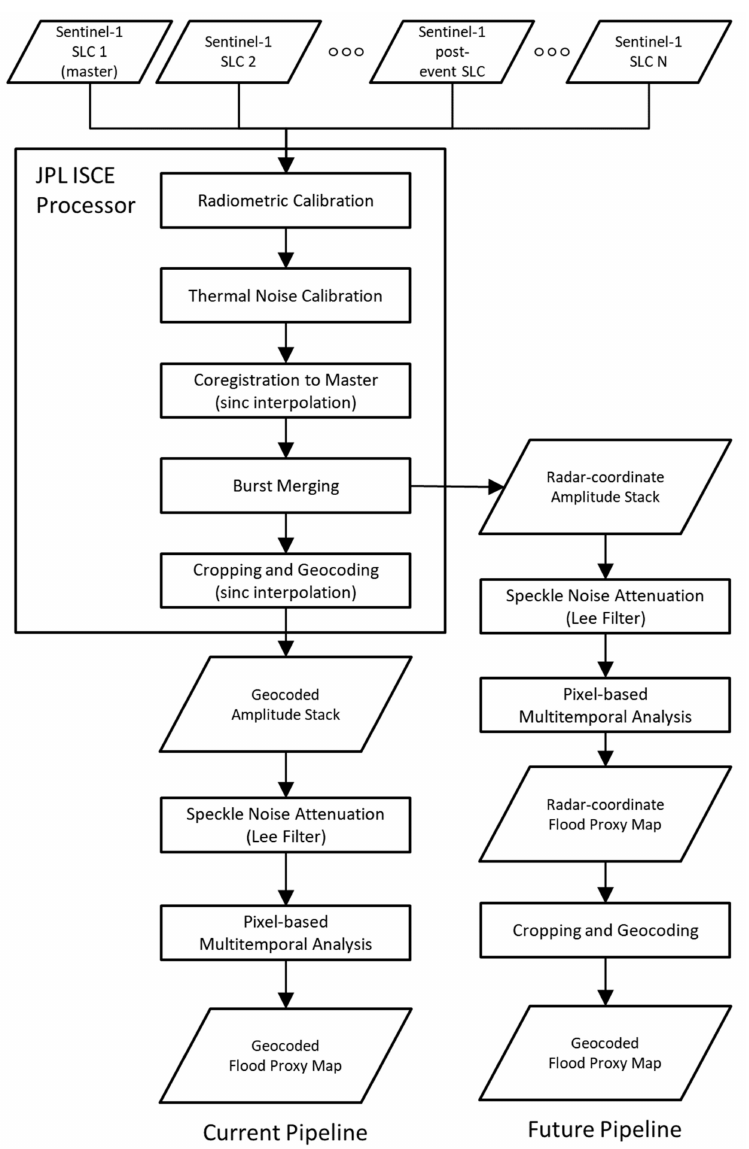
Figure 3. The processing flow chart for the intensity stack and flood proxy map. JPL ISCE, Jet Propulsion Laboratory’s InSAR Scientific Computing